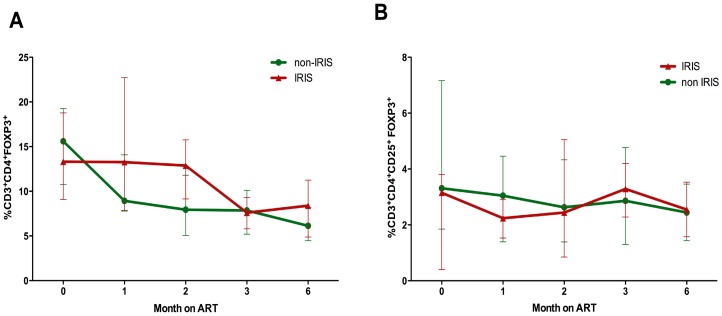
Change in T regulatory cells in IRIS and non-IRIS patients after the initiation of antiretroviral therapy.A) Percentage of total CD3+CD4+FOXP3+ T cells or B) CD3+CD4+CD25+FOXP3+ after initiation of ART till six months post ART. The trend lines denote the median percent values for each group over the 6-month study period.